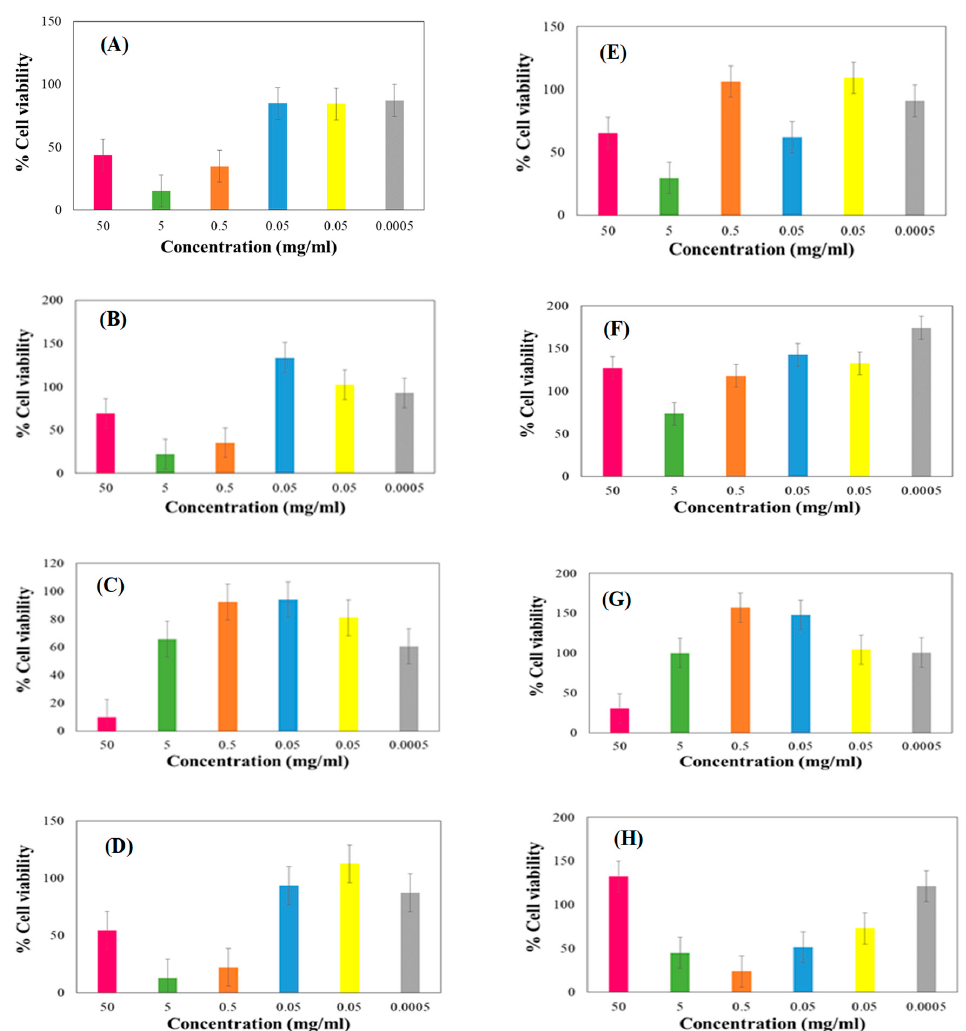
Figure 9. HepG2 cell biocompatibility levels measured by NR assay ( A ) placebo, ( B ) drug-loaded, ( C ) pyrazinamide and ( D ) rifampicin and Caco2 cell biocompatibility levels measured by NR assay ( E ) placebo, ( F ) drug-loaded, ( G ) pyrazinamide and ( H )